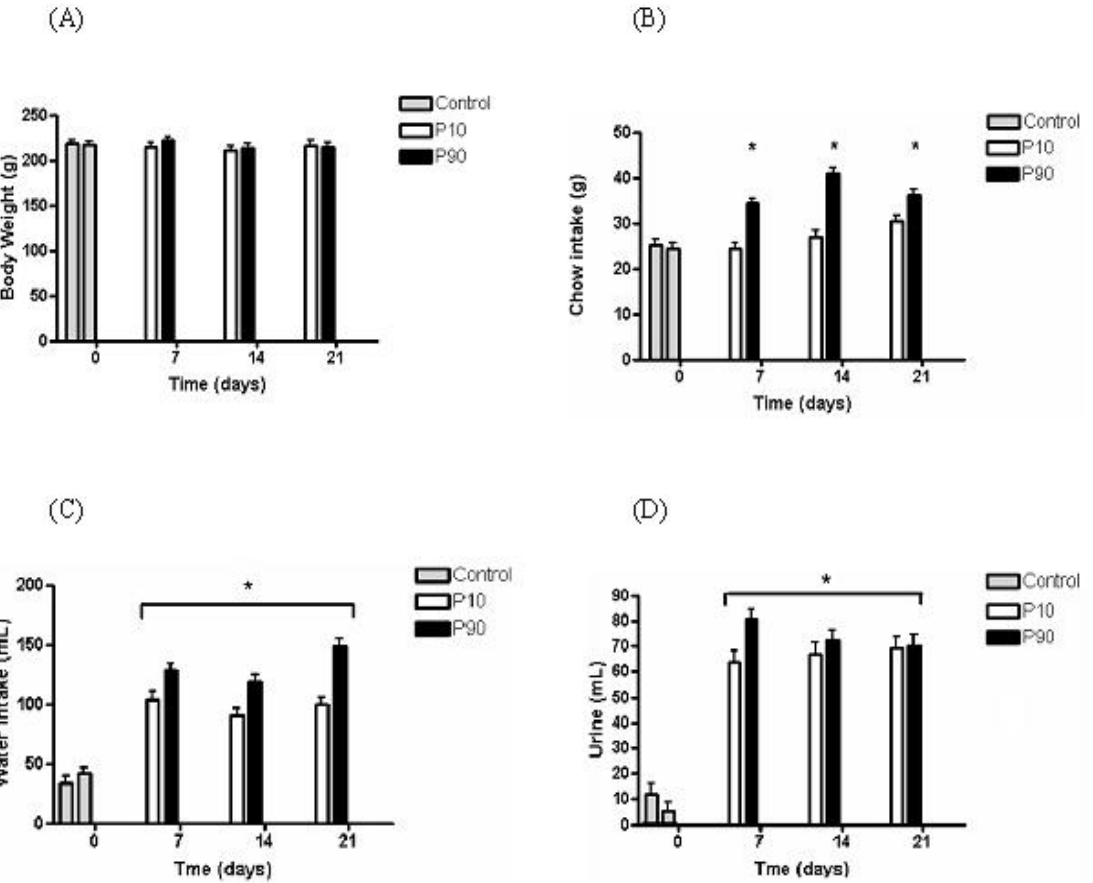
Figure 2. Body weight ( A ), chow intake ( B ), water intake ( C ) and urine volume ( D ) of control group and propolis treated rats (P10 or P90) after 7, 14 and 21 days of streptozotocin administration. *Significantly different from day 0 (p <